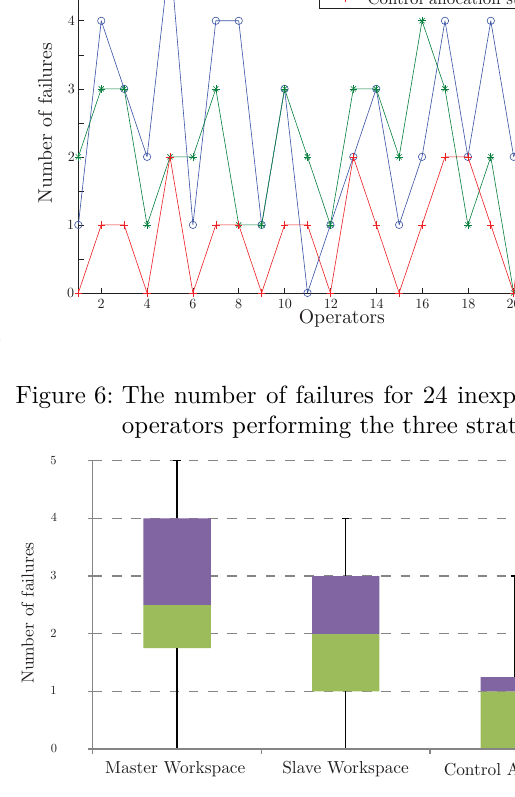
Figure 7: The median, the maximum, 75th percentile, 25th percentile and minimum values of num- ber of failures.